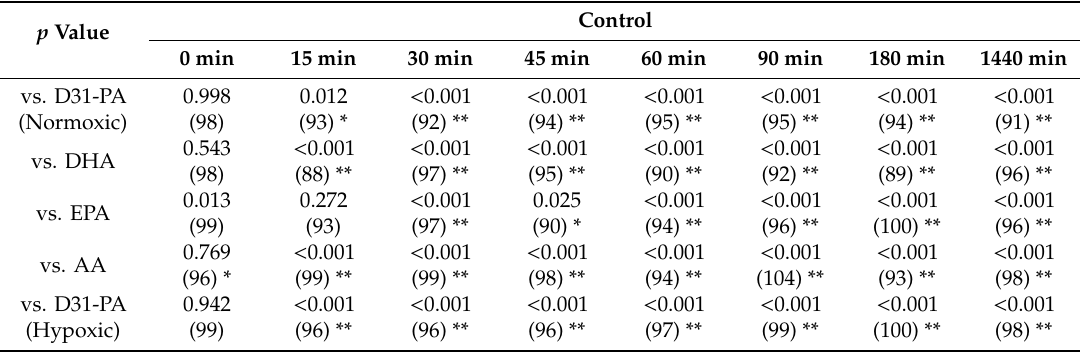
Table A3. The p values of the two-tailed t -tests comparing the uptake of D31-PA in the control experiment with other treatments. * is significant at 0.05 confidence level and ** is at 0.01 confidence level. n values are shown in the